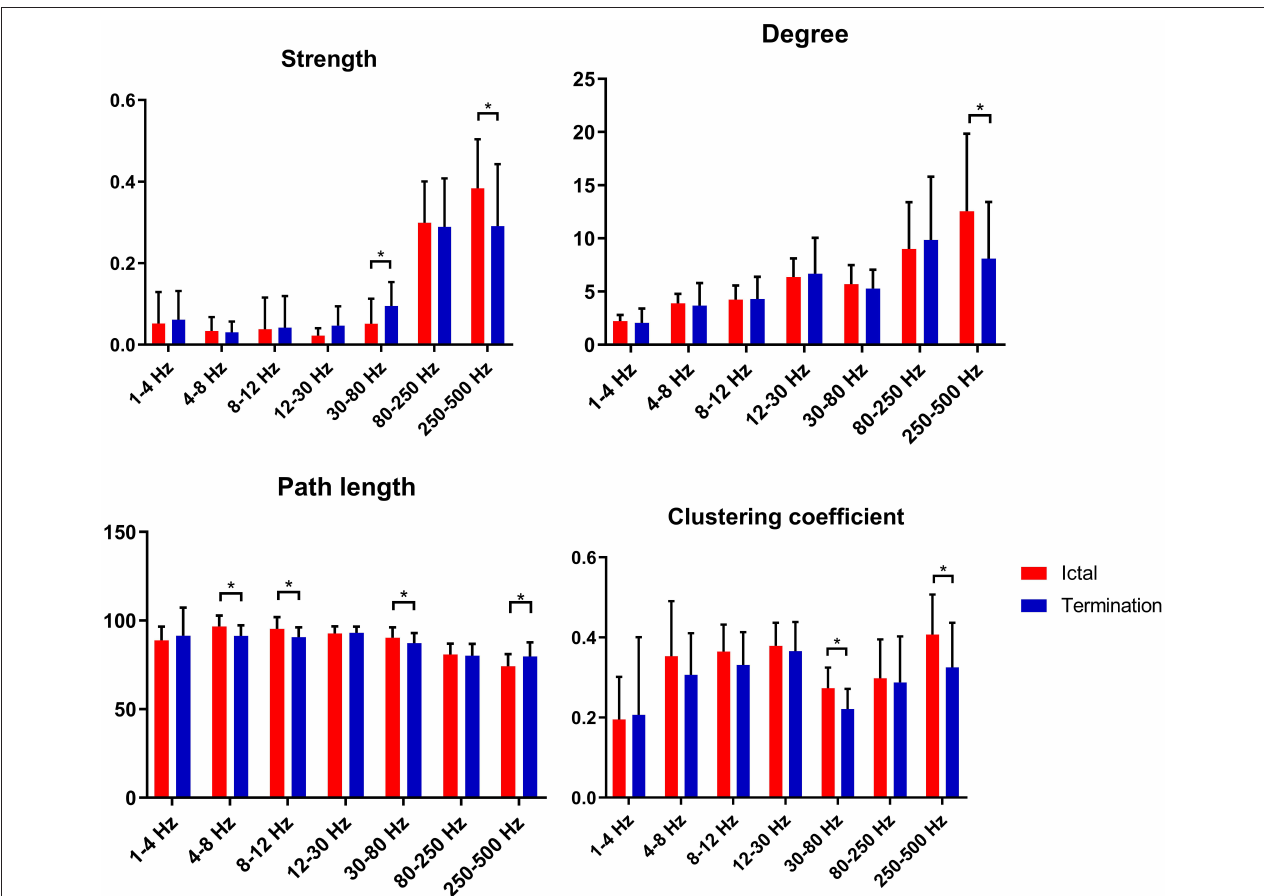
FIGURE 4 | Changes in topological parameters (strength, degree, path length, and clustering coefficient) of FC networks between two groups. P * < 0.05 after FDR and Bonferroni